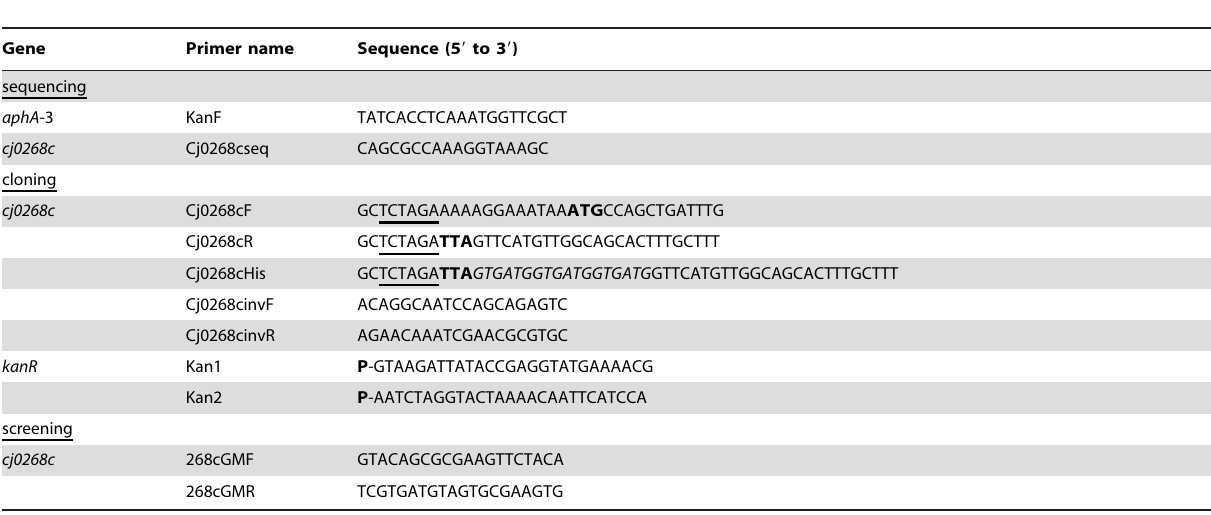
Table 1. Oligonucleotide primers used for sequencing, cloning of the C. jejuni gene cj0268c with and without His-tag, generation of the knockout mutant and screening of genomic DNA samples for the presence of cj0268c